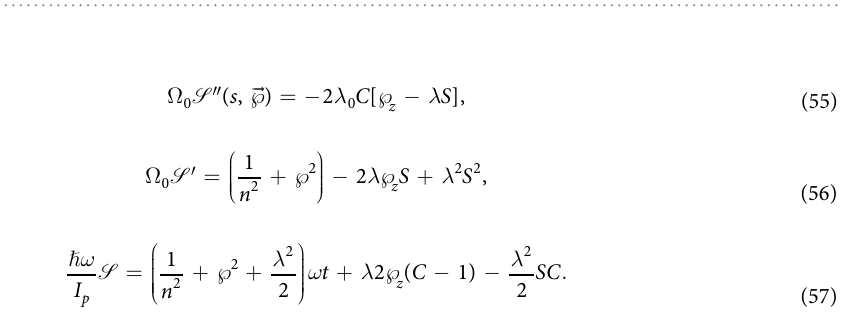
s Figure 2. The red curve is ∫ Σ = ′ ′ ′ s g s s ds ( ) ( )cos(10 ) with pulse envelope = − g s s s ( ) (2 ) , showing c 0 nonperiodic values of stationary points on s when the curve intersects the (blue) dash line which represents a constant value on the right hand side of Eq. 46. The black curve is ∫ ′ ′ s ds cos(10 ) s giving the periodic 0 intersection